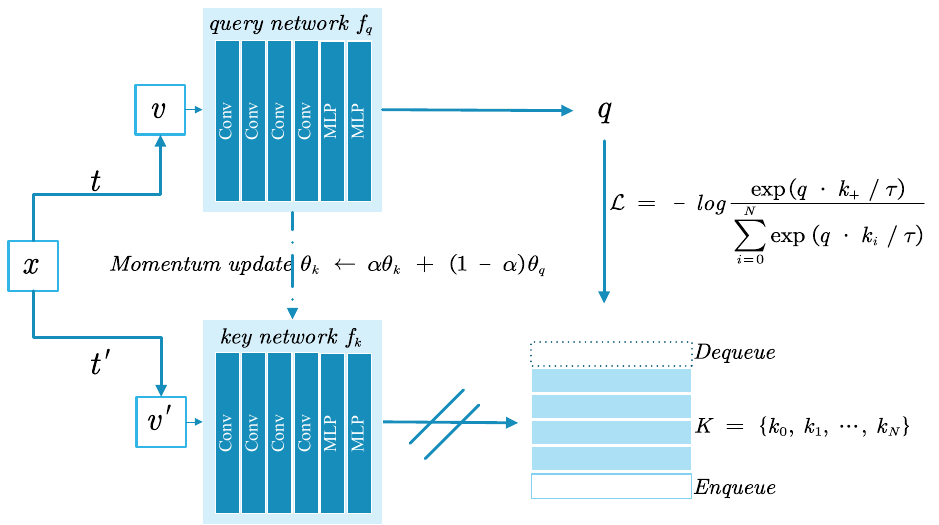
Figure 1. The framework of the MoCo network.